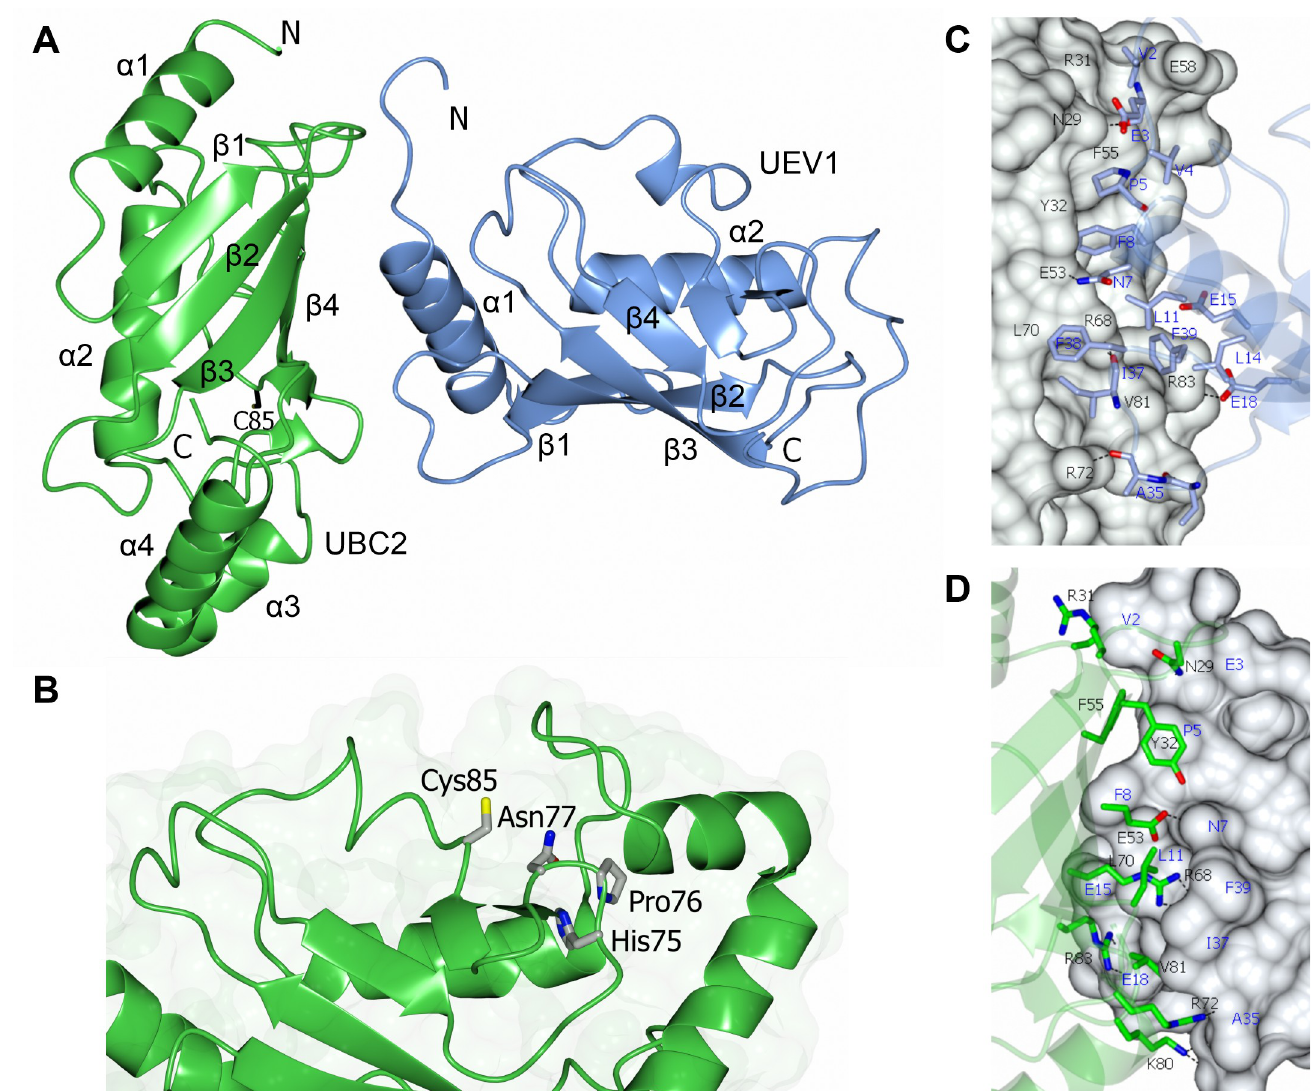
Fig 4. Structure of the UBC2-UEV1 heterodimer. A Ribbon diagram showing the crystal structure of UBC2 (green) and UEV1 (blue) in complex. The location of the N- and C-termini are highlighted along with the numbering of alpha helices ( α ) and beta strands ( β ). B Zoom-in of the conserved catalytic residues in UBC2. The HPN motif and proposed catalytic cysteine are shown as cylinders coloured by atom (red, oxygen; blue, nitrogen; yellow, sulfur). C-D Zoom-in of interface between UBC2 and UEV1 with UBC2 or UEV1 as a surface fill model respectively. Amino acid residues are shown as cylinders coloured by atom (red, oxygen; blue, nitrogen). Hydrogen bonds are denoted by dashed